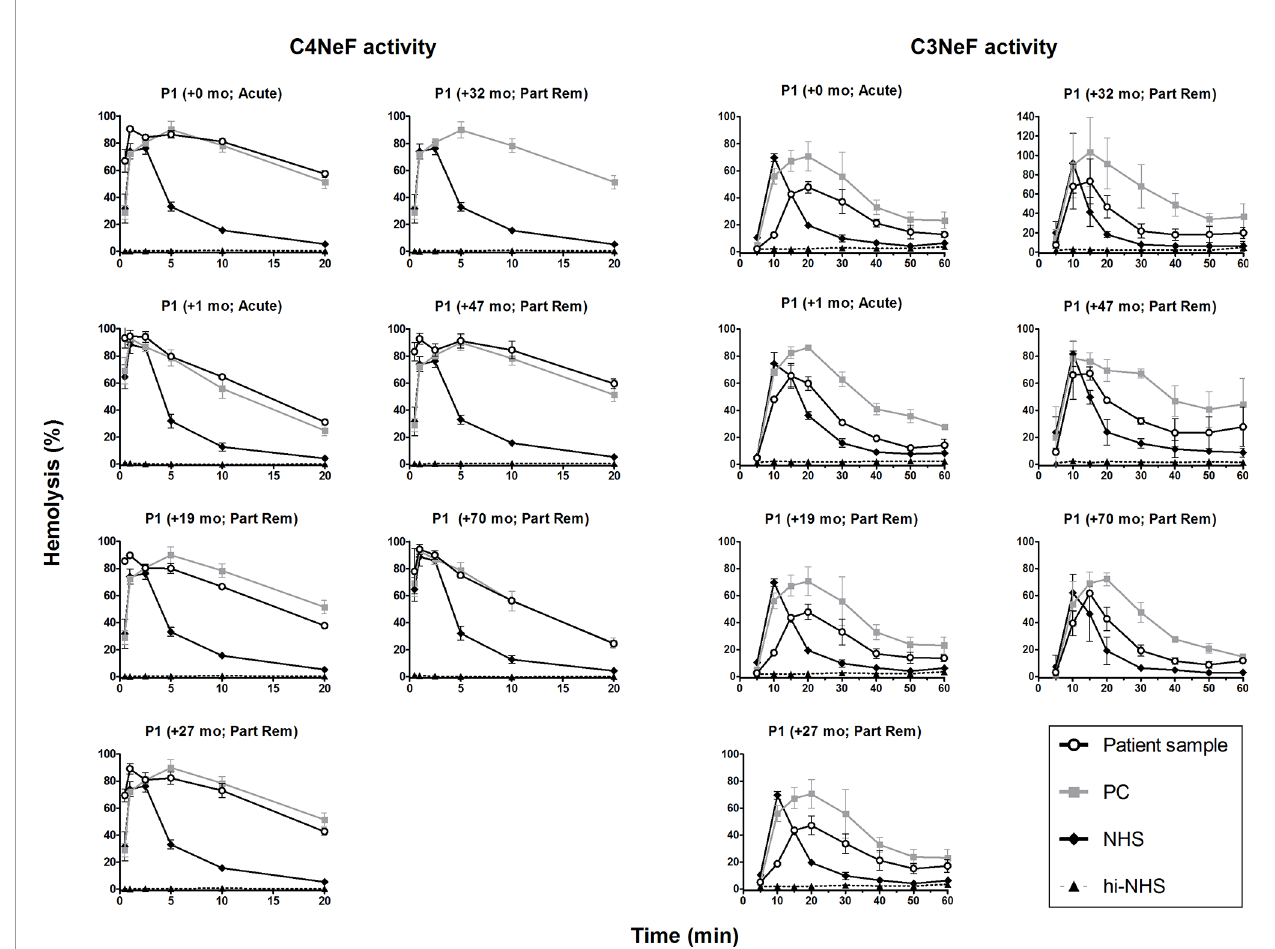
FIGURE 6 | C4 nephritic factor and C3 nephritic factor activity of patient P1 during follow-up. Samples from P1 collected over the disease course were tested for prolonged classical pathway activity, i.e. C4 nephritic factor (C4NeF) activity, and for prolonged alternative pathway activity, i.e. C3 nephritic factor (C3NeF) activity. Collection dates are presented as time after acute presentation in months (+mo). Hemolysis levels are presented as percentage of full lysis of erythrocytes in water. Results are shown as mean and range of two independent experiments. For the C4NeF activity assay, the positive control (PC) is the sample of P1 collected 32 mo after presentation. Part Rem, partial remission; NHS, normal human serum; hi-NHS, heat-inactivated